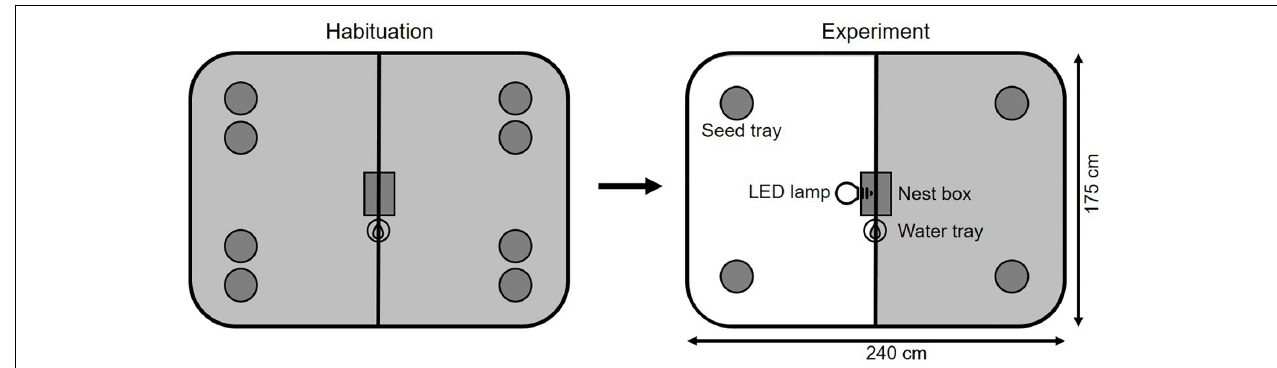
FIGURE 1 | Experimental arena with seed trays containing 450 ml sand and 0.6 g millet. Each of the arenas was divided by a wall into two compartments of equal size. The separating wall stopped 10 cm above the ground so that the animals were able to move freely around the whole arena. Number of seed trays was halved from the habituation phase to the experimental phase as seed trays were exchanged once a day in the habituation phase and twice in the experimental phase. The habituation phase was characterized by dark nights, in the experimental phase one side of the arena was artificially illuminated at night.